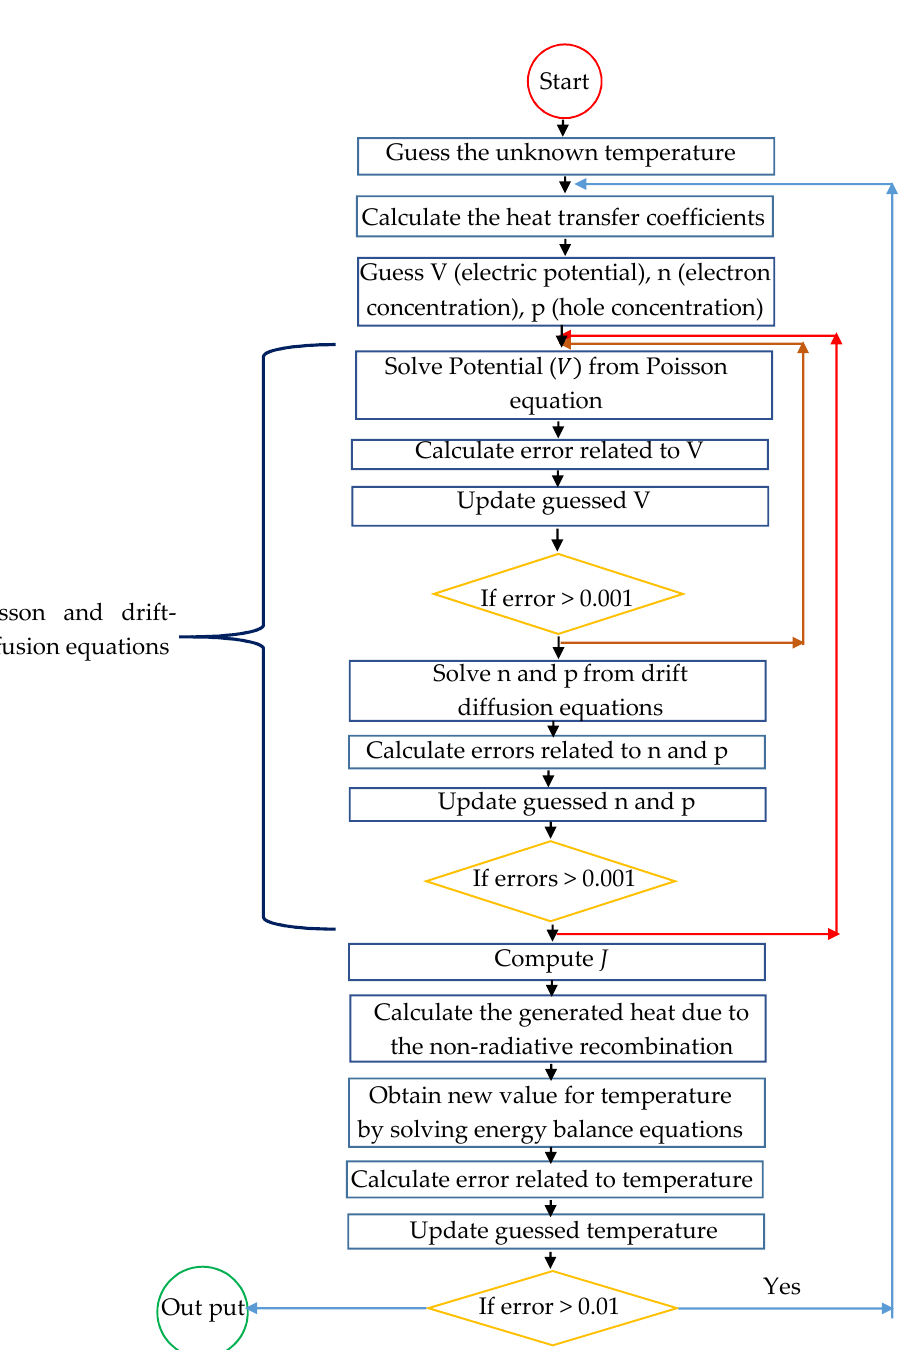
Figure 4. The data flow chart for solving the proposed simulation.